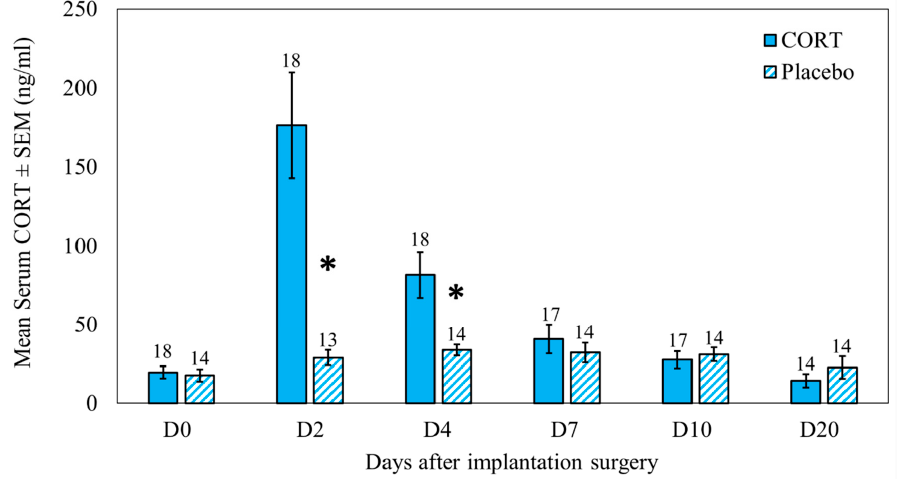
Figure 1. Serum CORT levels (mean ± SEM) before (D0), during (D2, D4), and after (D7, D10, D20) the active-pellet period from lesser scaup ( Aythya affinis ) that received either a 10-day slow-release cholesterol-based biodegradable CORT pellet (CORT) or placebo pellet that did not contain any hormone (control) on D0. Sample sizes are stated on each error bar. The asterisk (*) denotes statistical significance at p < 0.05.